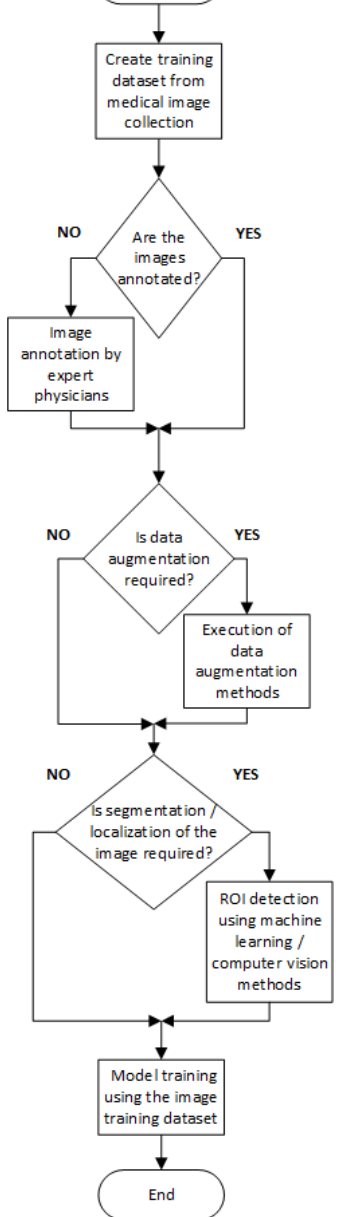
Figure 2. General block diagram for training CNN models.